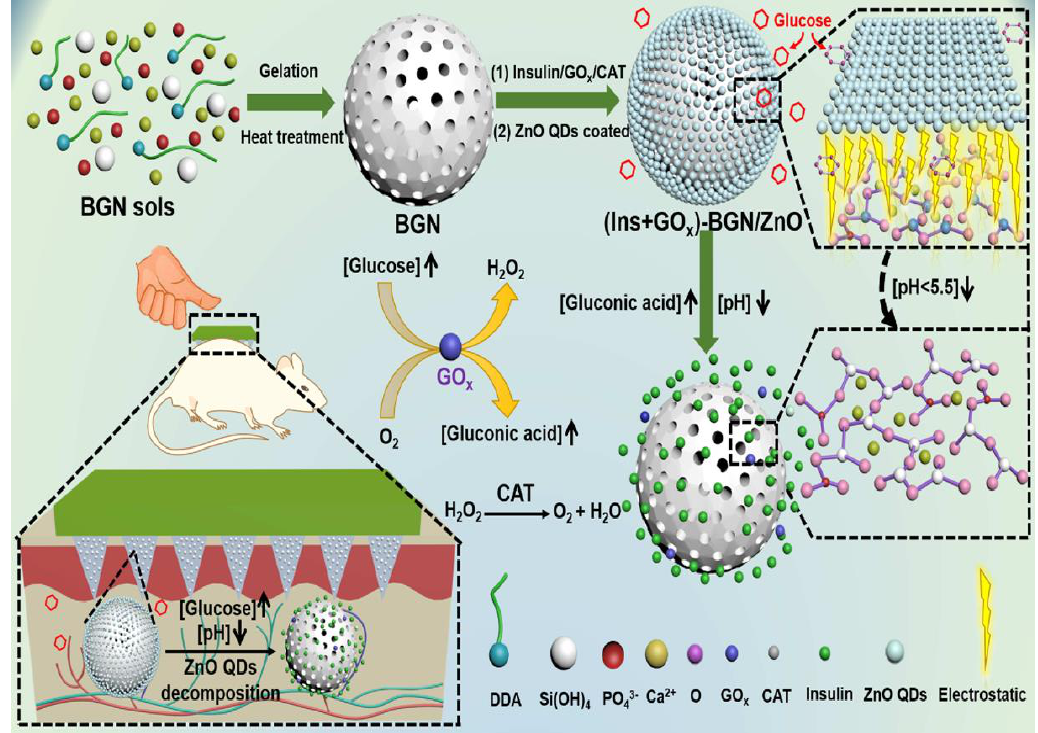
Figure 7. Schematic presentation of the ZnO quantum dots QDs which capped the pores of mesoporous bioactive glass NPs (MBGNs) integrated with PVP MNs for the glucose mediated TDD of insulin. After penetration into the skin and participation in the body circulation, GOx and CAT in the MBGs convert glucose to gluconic acid, resulting in decreasing the local pH and dis-assembly of ZnO QD caps, leading to the opening of MBGs’ nanopores and then releasing the insulin molecules. Reprinted with permission from [109] .